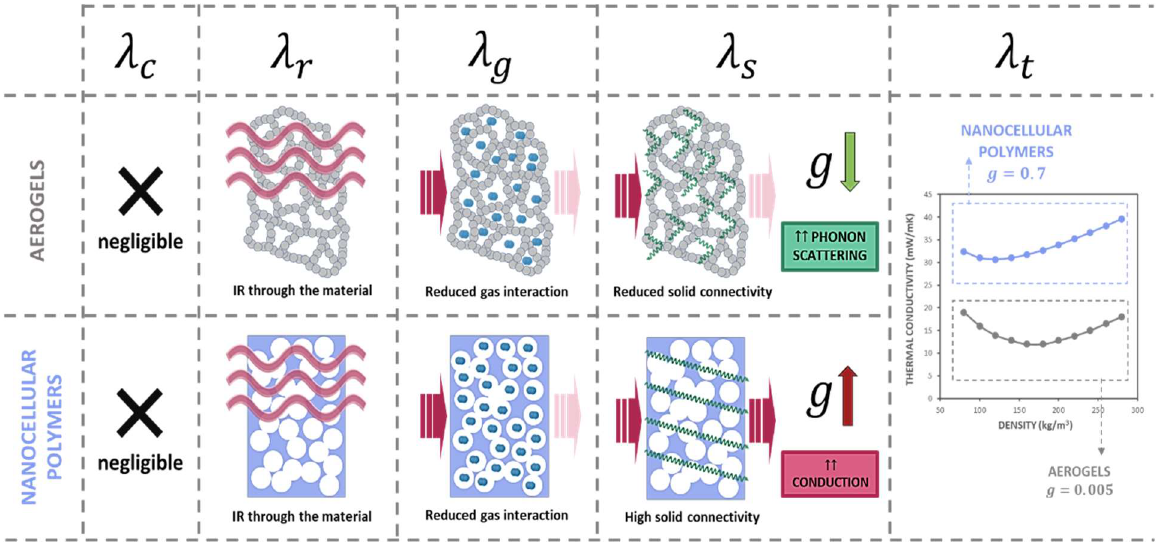
Figure 8. Heat transfer mechanisms in aerogels and nanocellular polymers. While both systems behave similarly in terms of radiation and conduction through the gas phase, there is a huge difference in the conduction through the solid material due to the intrinsic configuration of the solid phase. Nanocellular polymers show a connected solid phase, and as a result, higher conductivity.